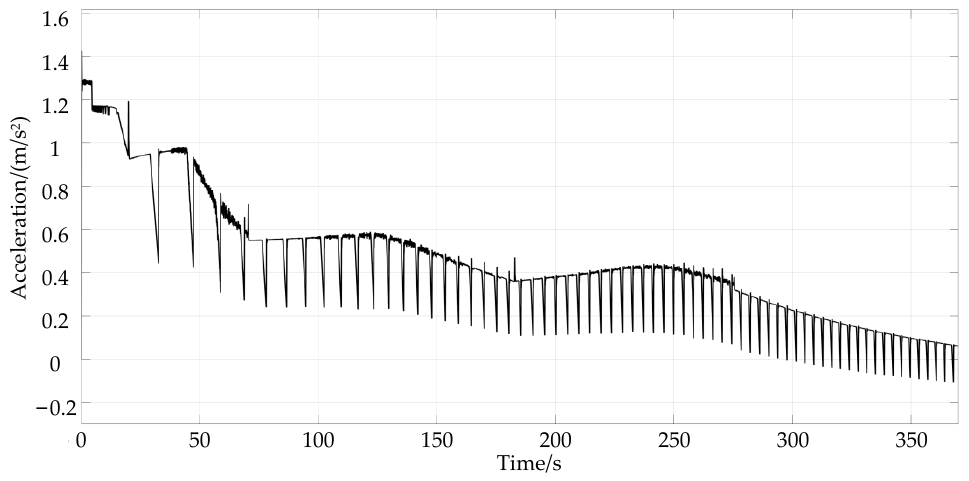
Figure 14. Acceleration curve of the train.